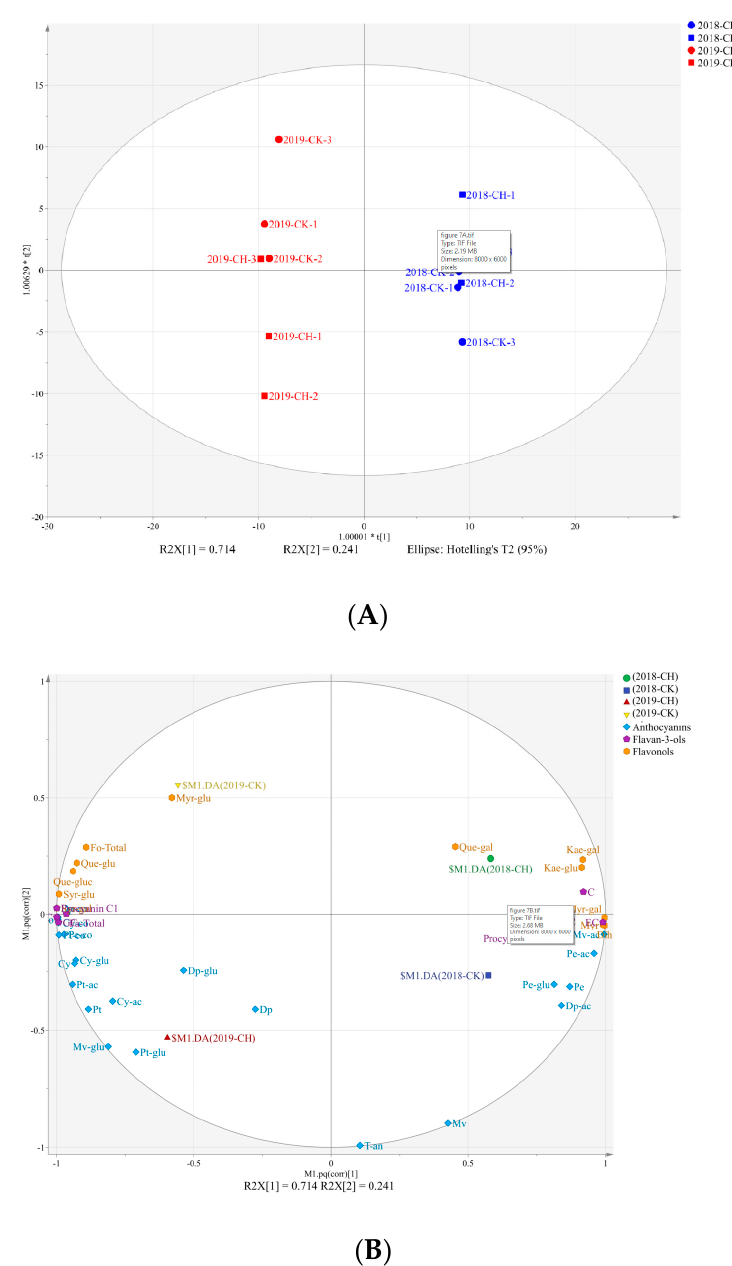
Figure 7. OPLS-DA based on volatile and flavonoids compounds concentrations separating wine samples according to vintage and treatment. ( A ) score scatter plot, ( B ) correlation loading plot.